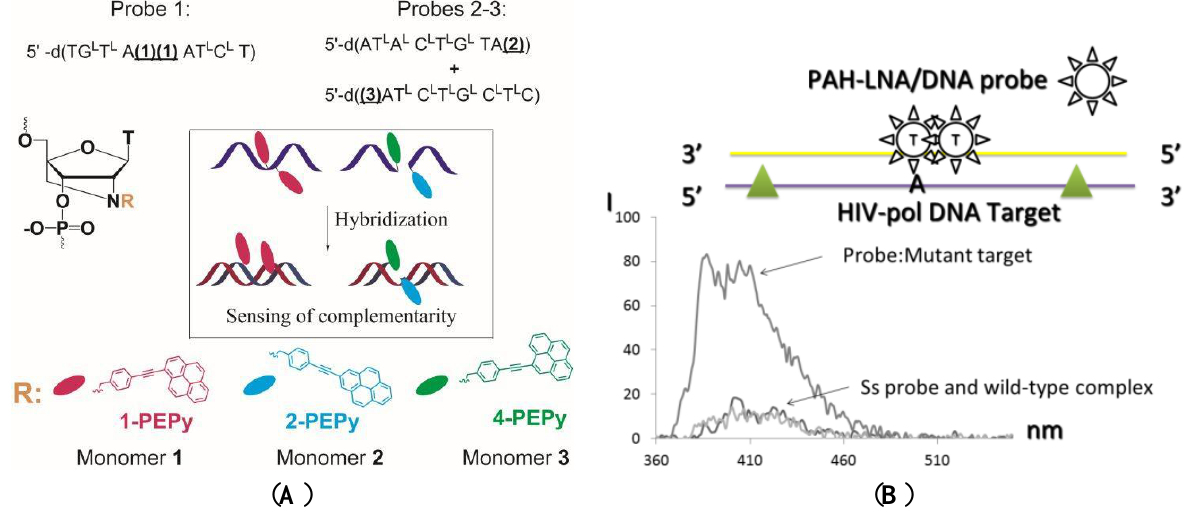
Figure 5. Polyaromatic hydrocarbon (PAH)-LNA/DNA probes in colorimetric assays for SNP detection [54]. HIV-pol = HIV-1 gene fragment encoding protease. ( a ) Chemical structures and design rules for the PAH-LNA/DNA probes, LNAs are marked with uppercase L; ( b ) Fluorescence spectra of single-stranded probe and its complexes with complementary (mutant) and mismatched (wild-type) DNA